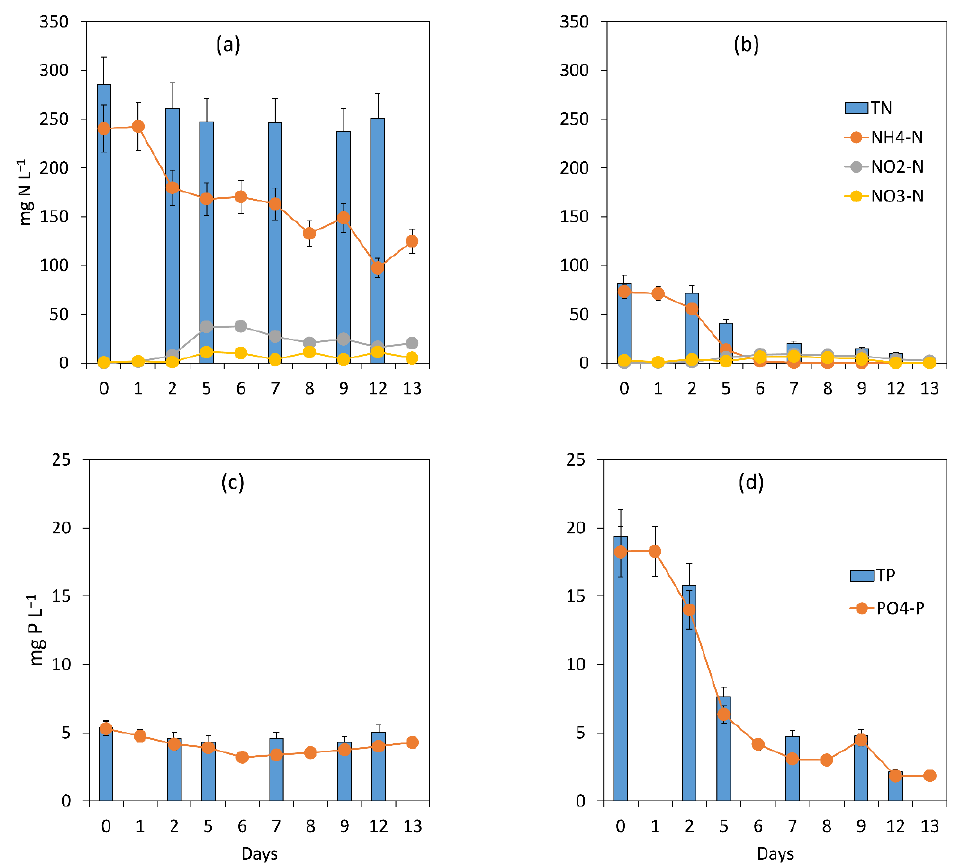
Figure 6. Concentration of nitrogen ( a) HL.X10.N, ( b ) HL.X10.P and phosphorus ( c ) HL.X10.N, ( d ) HL.X10.P in the reactors under the impacts of extreme N:P ratios.